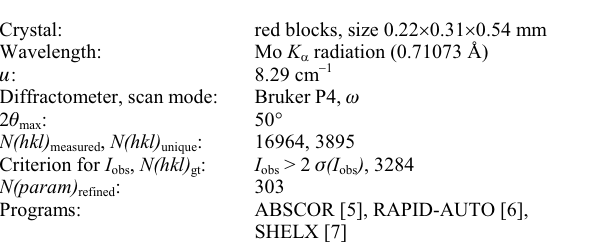
Table 1. Data collection and handling.